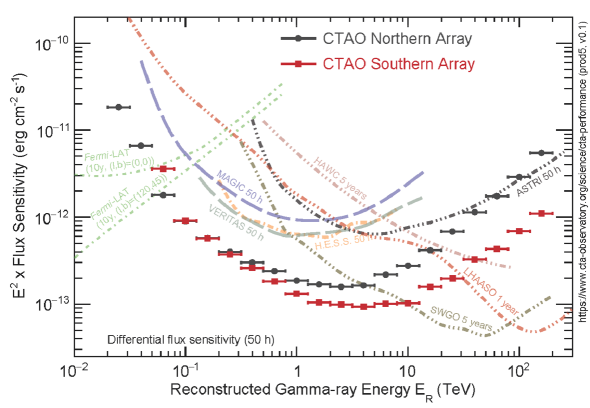
Figure 30. CTAO differential sensitivity 10 (defined as the minimum flux needed to obtain a 5- standard-deviation detection of a point-like source) for 50h of observations with the Northern and Southern array compared to the sensitivity of several other Cherenkov telescopes and with Fermi-LAT (1